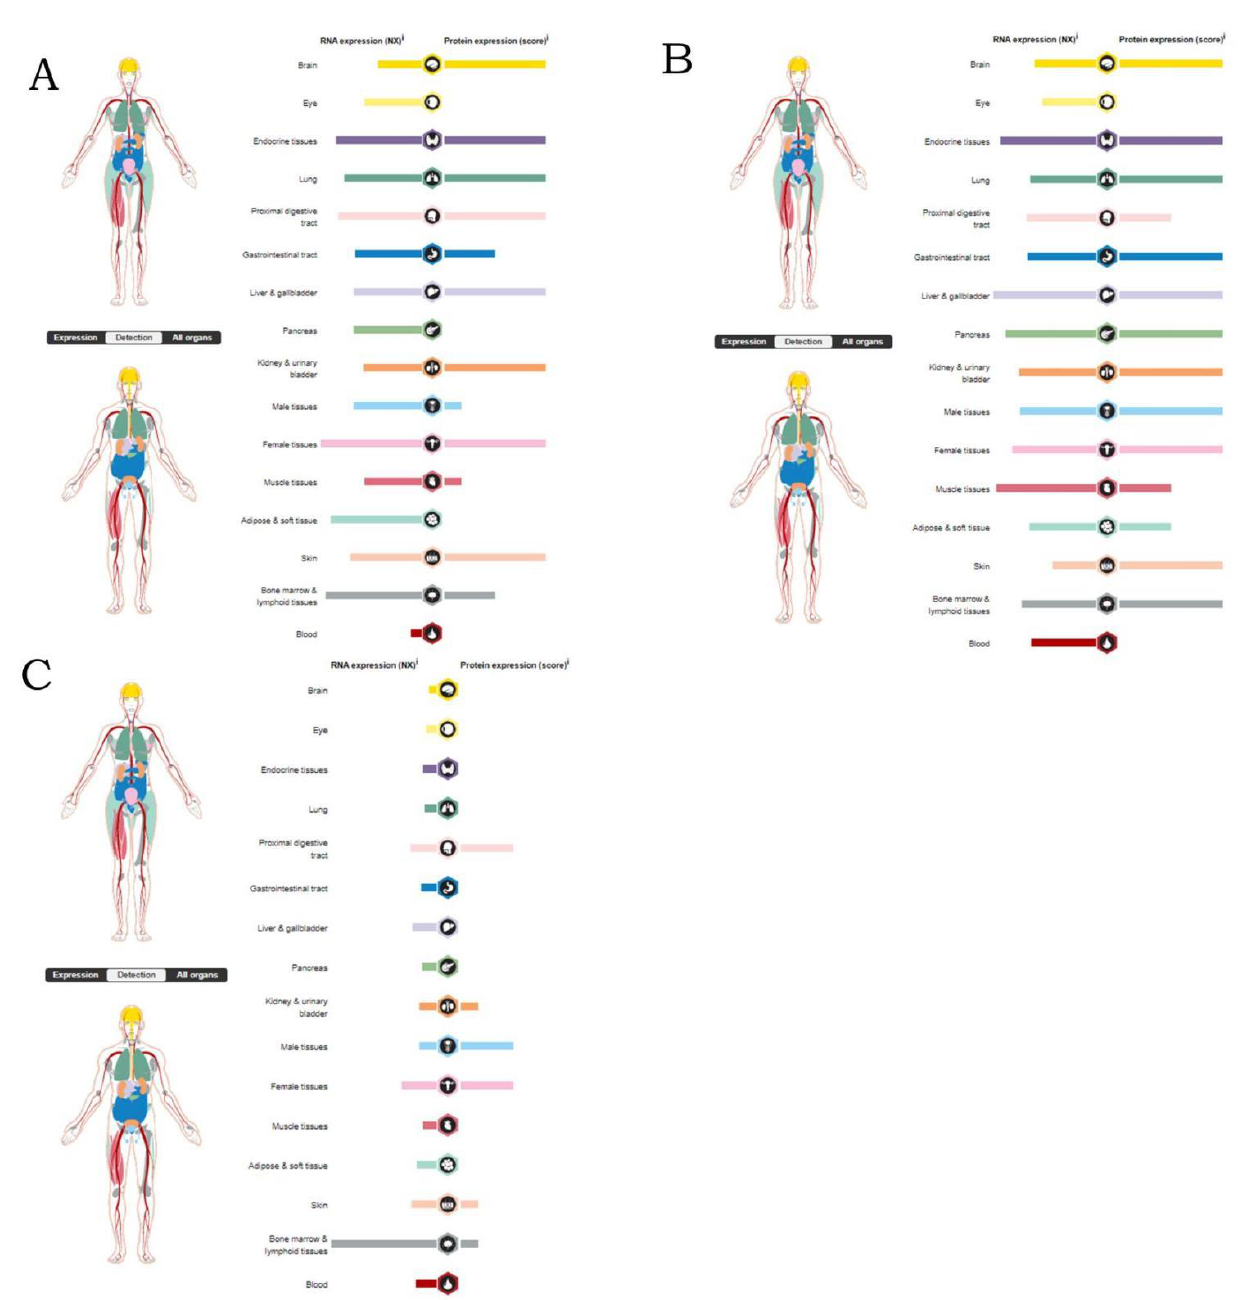
Figure 6. The distribution of genes that are related to colonic neoplasms and breast neoplasms in human organs: ( A ) JUN; ( B ) AKT1; ( C ) TP53.